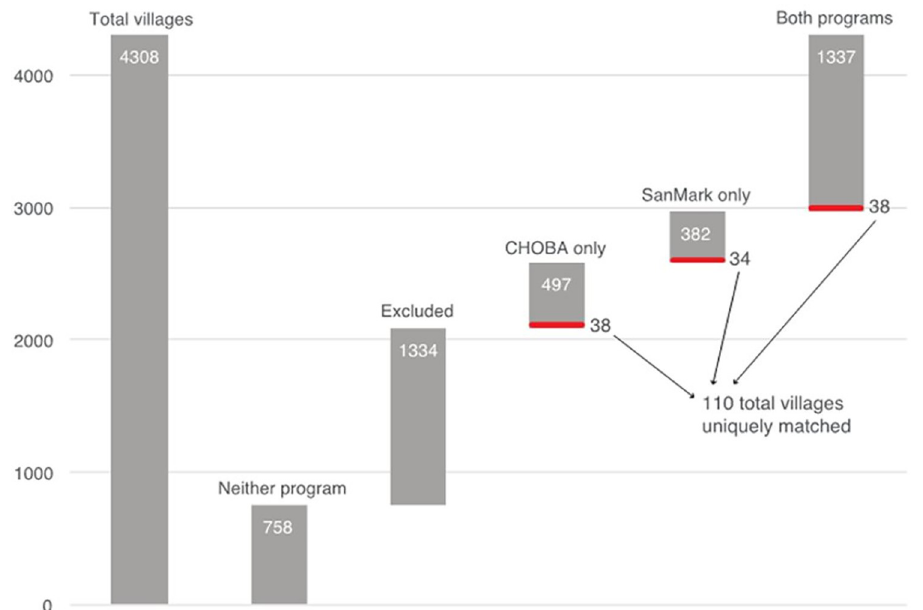
Fig 2. Overview of village screening approach.